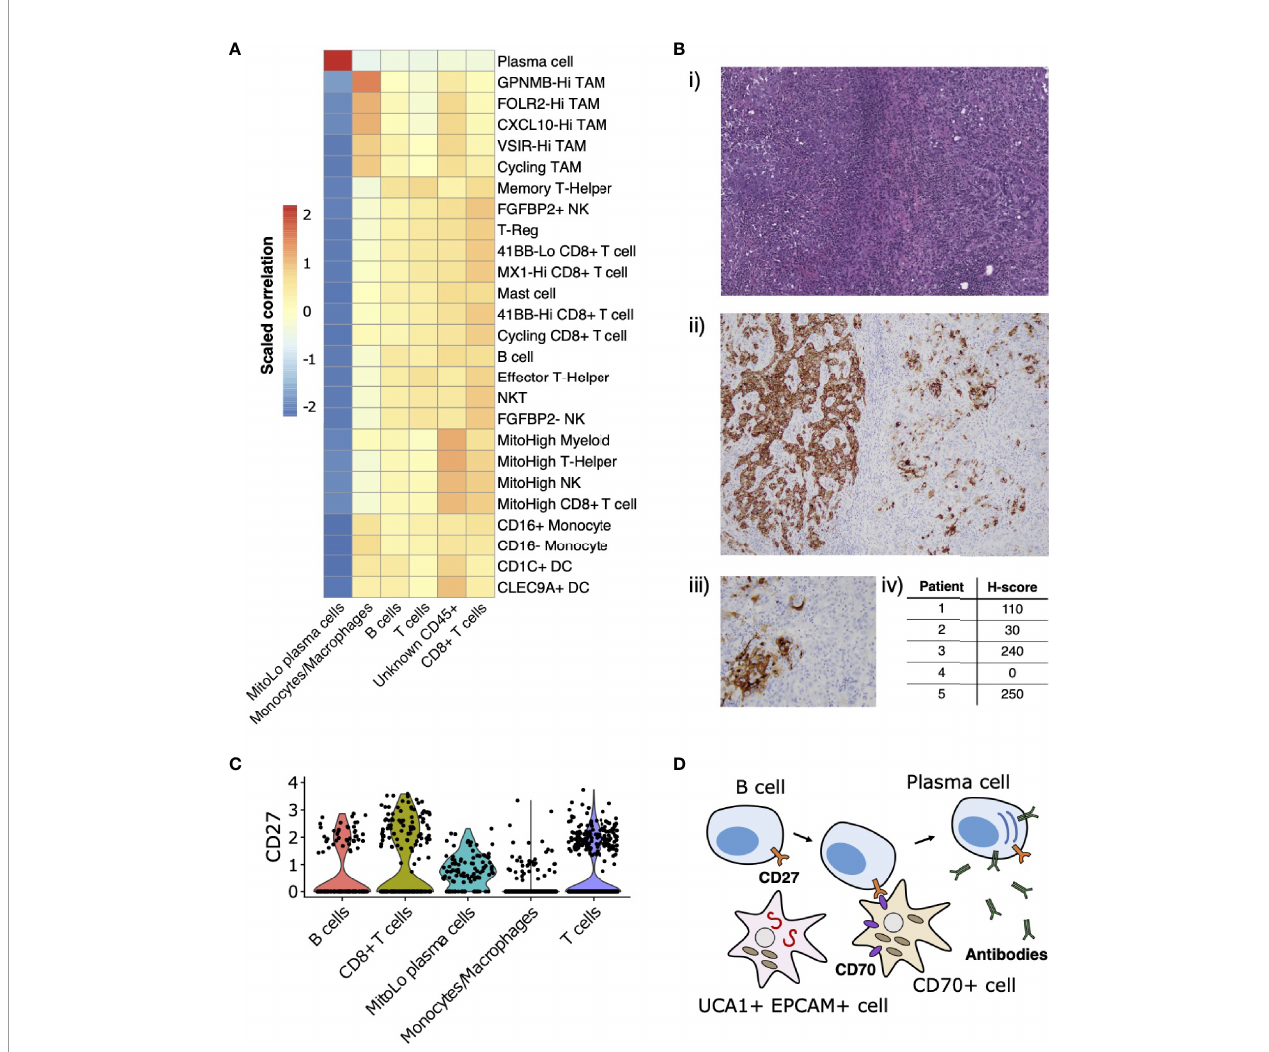
FIGURE 4 | Immune landscape and cross-talk in the RMC tumor microenvironment. (A) Correlations between transcriptional pro fi les of immune cell types identi fi ed in RMC and ccRCC, respectively. (B) CD70 immunohistochemistry: (i) representative HE images of tumor regions from Patient 1; (ii) corresponding CD70 immunostaining of tumor regions from Patient 1; (iii) heterogenous CD70 immunoreactivity of tumor cells at high magni fi cation; (iv) H-score for fi ve RMC tumor samples (including Patient 1; H-score = 110) assayed for CD70 protein expression. (C) Violin plot displaying normalized log 2 expression of CD27 across immune cell clusters in the RMC tumor from Patient 1, where normalization was originally performed over all cells. (D) Cartoon schematic illustrating a putative role for the CD70 - expressing tumor cell sub-population in co-stimulation of plasma cell differentiation via the CD27